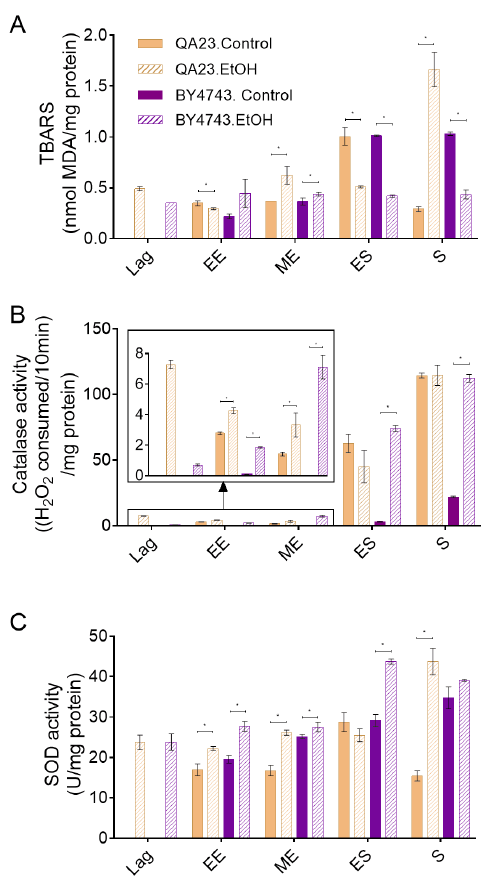
Figure 4. Effect of 8% ethanol on the S. cerevisiae strains BY4743 (purple) and QA23 (orange) on ( A ) lipid peroxidation (nmol TBARS/mg protein), ( B ) catalase activity ((H 2 O 2 consumed/10 min)/mg protein), and ( C ) superoxide dismutase (SOD) activity (U/mg protein). The parameters were calculated at different growth phases after the stress exposure: lag, early exponential (EE), mid-exponential (MD), early stationary (ES), and stationary (S). Solid columns, nonstressed cells; stripped columns, stressed cells. Lag phase was not observed for nonstressed cells. Error bars represent standard deviation, * indicates significant differences between stressed and nonstressed conditions ( p -value < 0.05), and in Supplementary Table S4, there is a more complete statistical analysis. TBARS stands for thiobarbituric-acid-reactive